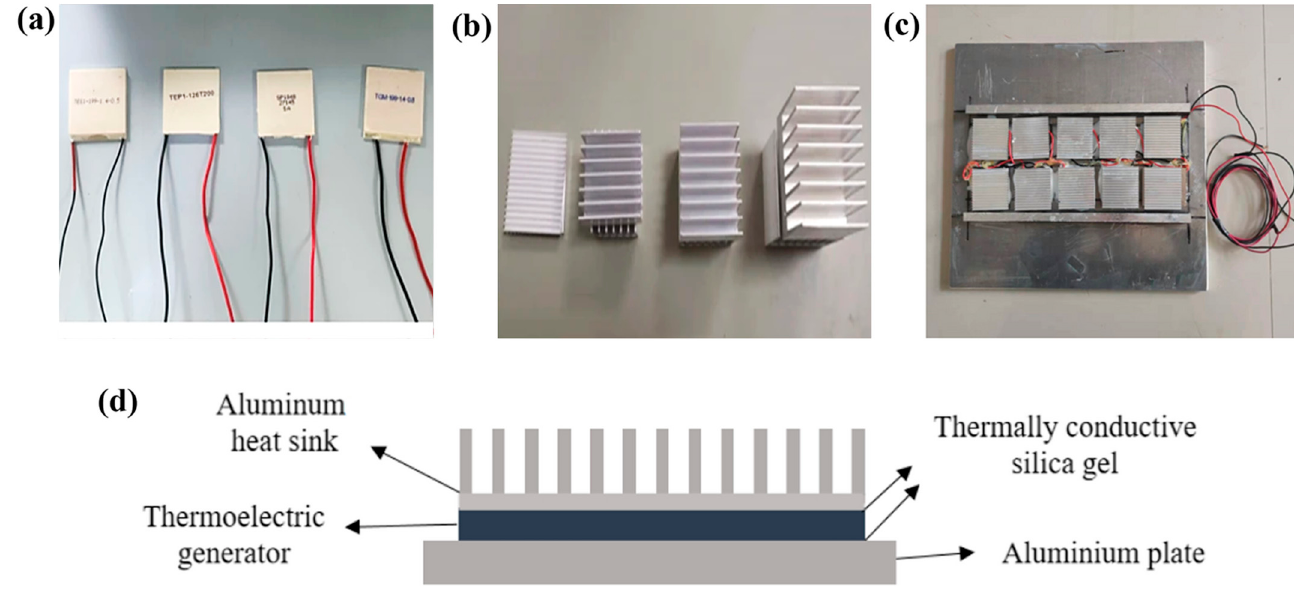
Figure 17. Thermoelectric system proposed by Xie et al.: ( a ) Four different commercial TEGUs. ( b ) Aluminum heat sinks. ( c ) TEGUs connected in series and arranged in a matrix. ( d ) Lateral view [74]. (Reprinted with permission from Ref. [74]. 2022, Springer Nature)